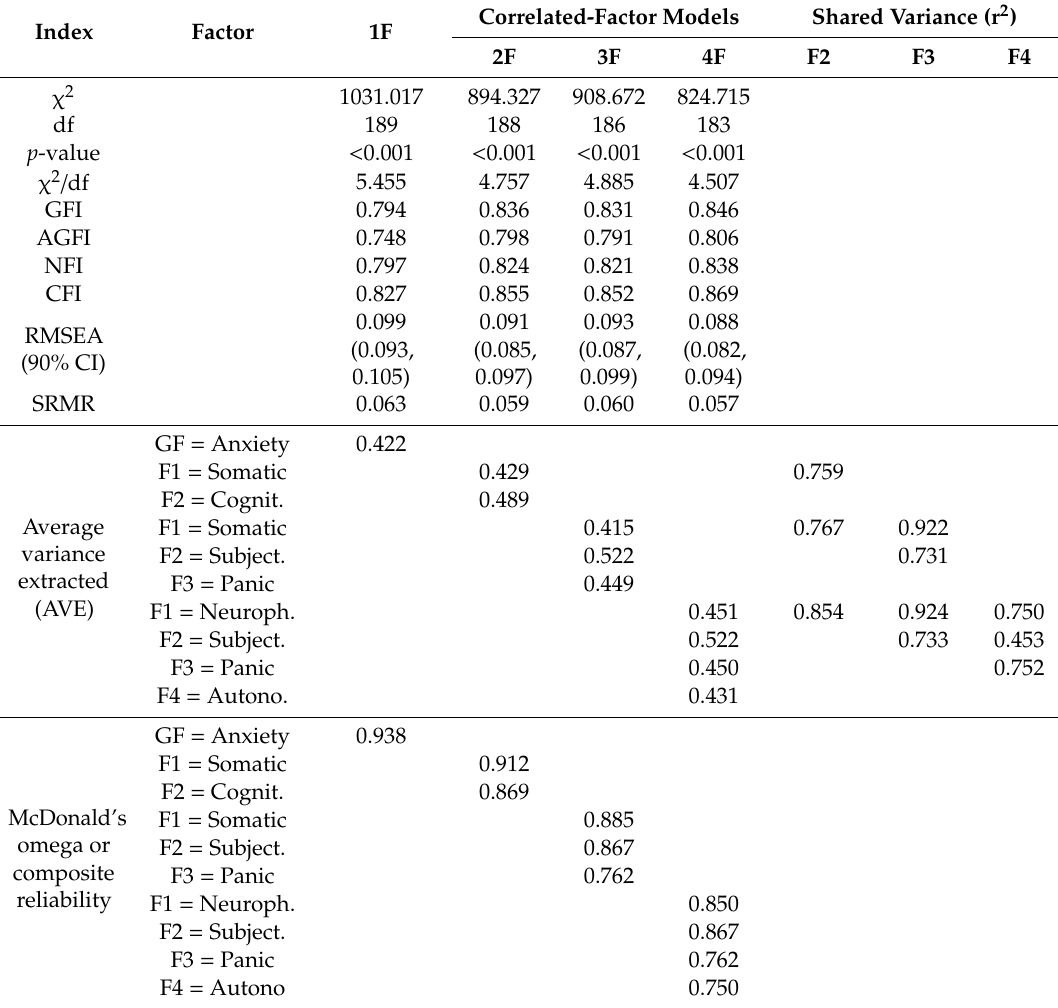
Table 2. Fit indexes of the one-factor model and the correlated-factor models originally proposed for the BAI as well as the AVE, shared variance and composite reliability of their